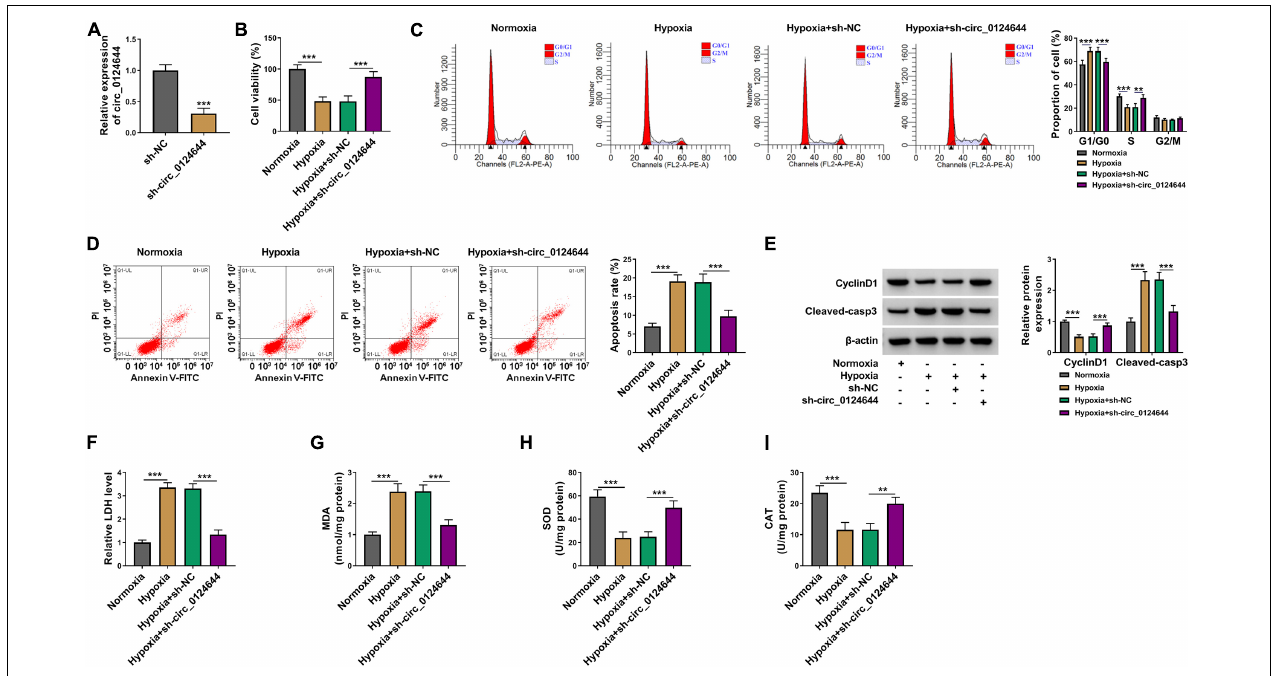
FIGURE 2 | The regulation of circ_0124644 silencing on hypoxia-induced cardiomyocytes injury. (A) AC16 cells were transfected with sh-NC or sh-circ_0124644. The expression of circ_0124644 was measured by qRT-PCR. (B–I) AC16 cells were transfected with sh-NC or sh-circ_0124644, followed by treated with hypoxia. AC16 cells treated with normoxia were used as control. (B) CCK8 assay was used to examine cell viability. (C,D) Flow cytometry was performed to detect cell cycle distribution and cell apoptosis. (E) The protein levels of CyclinD1 and Cleaved-casp3 were determined using WB analysis. (F–I) Corresponding Assay Kits were used to assess the levels of LDH, MDA, SOD, and CAT. ** P < 0.01, *** P < 0.001.